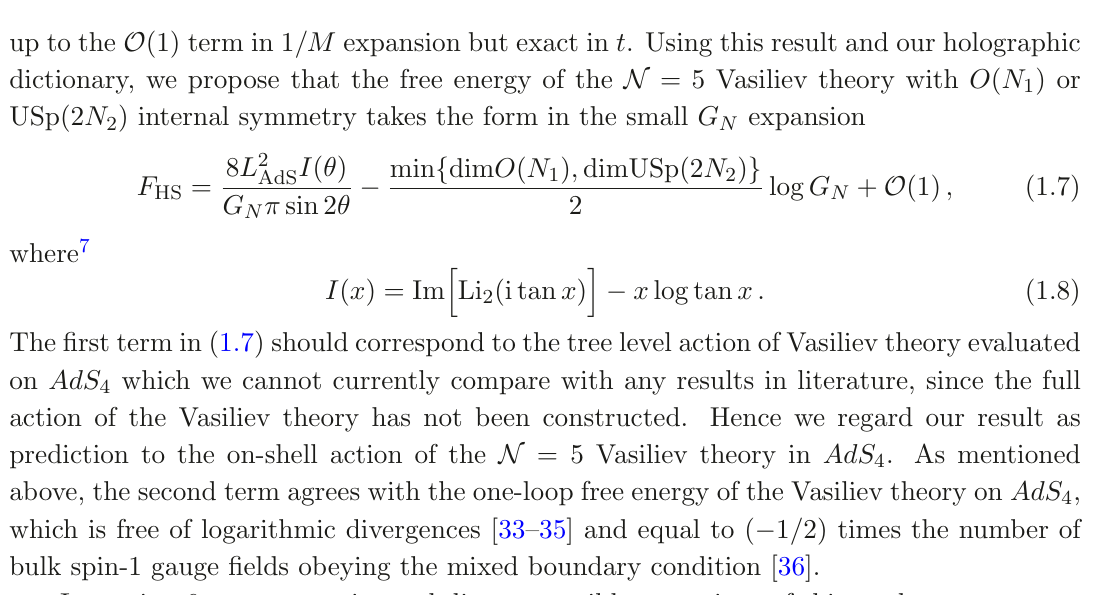
Figure 4 . Identification of degrees of freedom corresponding to those of the Vasiliev theory from the viewpoint of the brane construction. Strings denoted by the red solid lines are the HS degrees of freedom while the blue dashed line is what we are